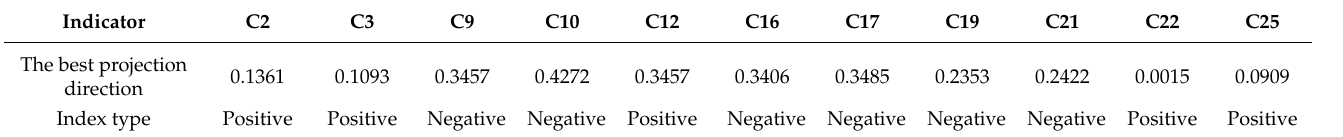
Table 3. Representative indicators with a relatively large weight from each